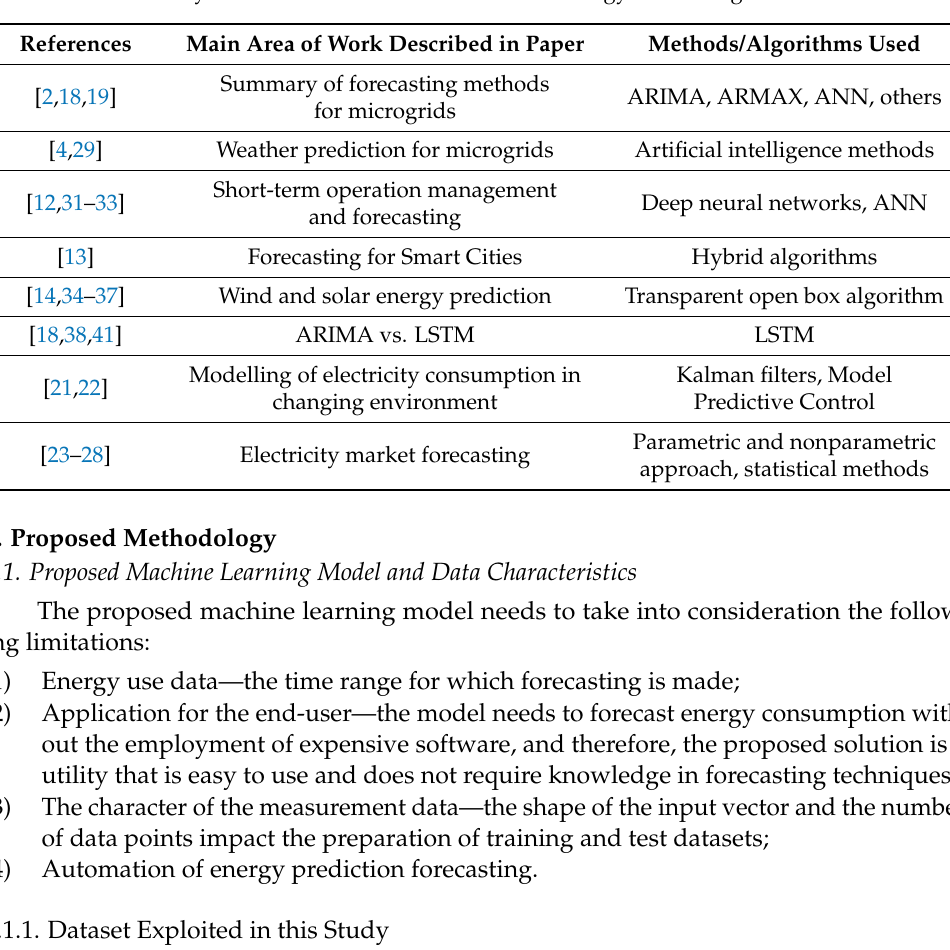
Table 1. The summary of research studies associated with energy forecasting.